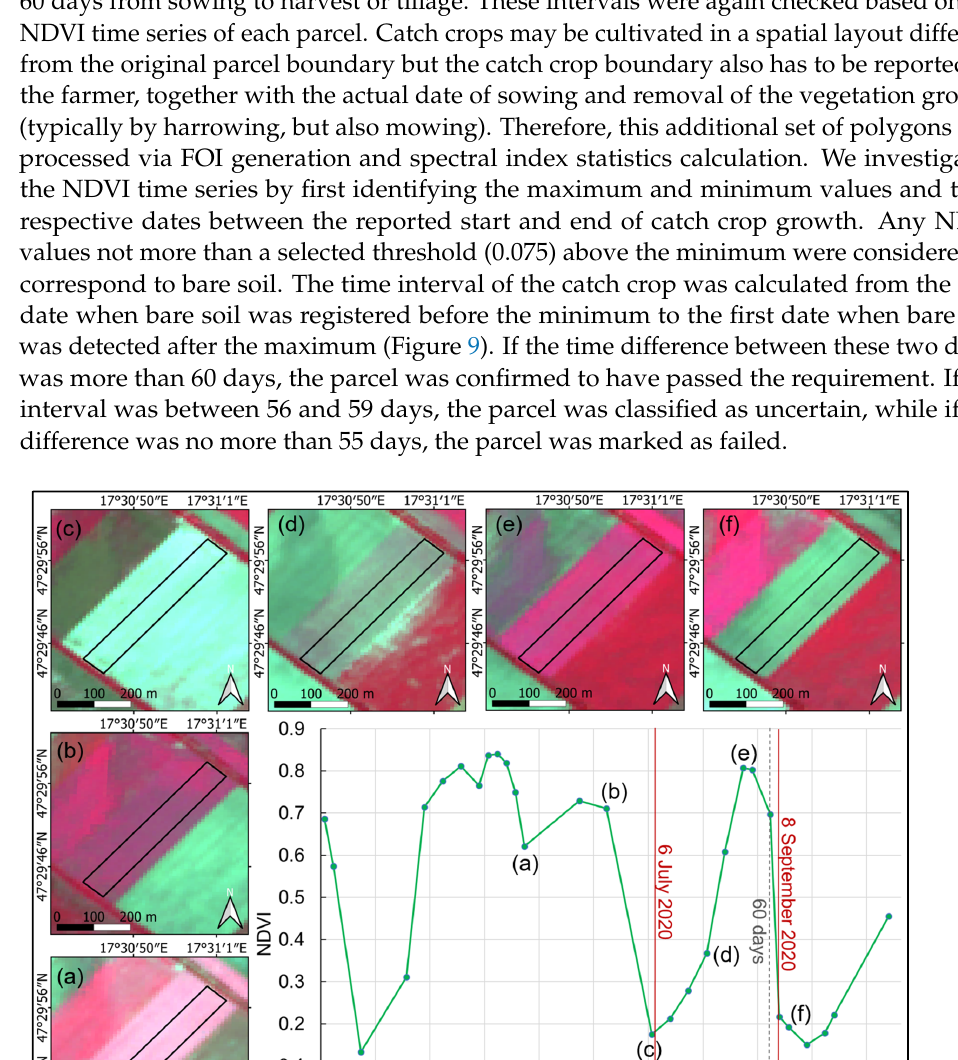
Information on cultivation events was validated using a purpose-built QGIS plugin that allowed for visualization of satellite imagery together with the Geospatial Aid Appli- cation (GSAA) database geometries and attributes. The accuracy of mowing detection was evaluated on a total of 160 parcels, with at least 30 parcels for each relevant vegetation class (alfalfa 10 samples) from one selected agroecological zone. Negative control samples were also selected for grassland and fallow land categories (GRAS_NM and FLAND_NM) to detect false positive errors.